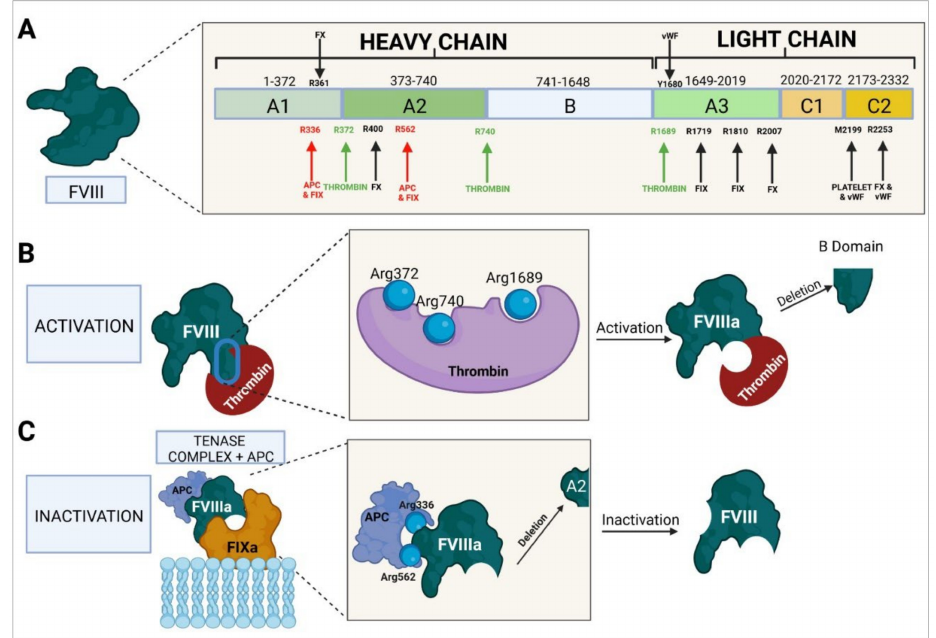
Figure 4. Molecular characteristics of factor VIII. ( A ) Domain-based structure of the protein, sites at which it interacts with other factors and cofactors, and activation and inactivation sites. ( B ) Thrombin- mediated activation and B domain deletion. ( C ) APC-mediated inactivation and A2 domain dele- tion. FVIII, factor VIII; APC, activated protein C; FIXa, activated factor IX; FX, factor X; vWF, von Willebrand